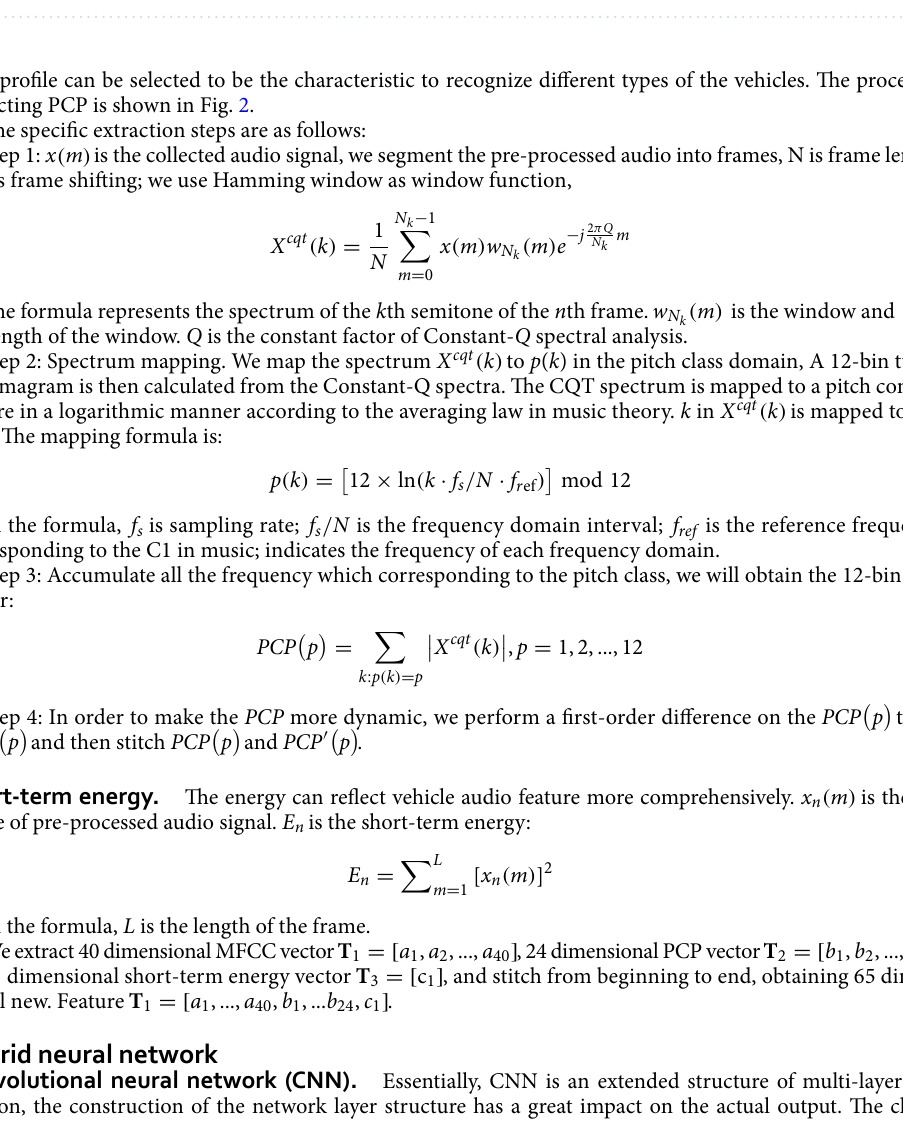
Figure 2. The process of extracting